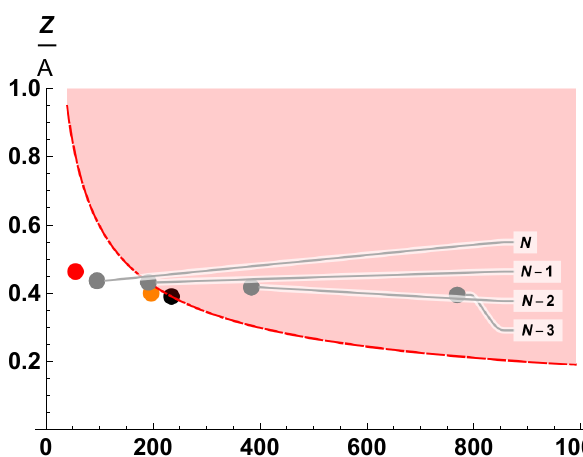
Figure 10. The final stage of a fission-cascade leading to 92 Mo. Gray dots show 92 Mo (label N) and its three generations of “ancestors” ( N − 1, N − 2, N − 3), each of which simply splits in two, and parametrized adjustment for the “loss” of neutrons due to n - and β - emissions is included at each fission event. In the shaded red zone, fission takes place. Placements of Fe (red dot), Au (yellow dot), and U (black dot) are also depicted.